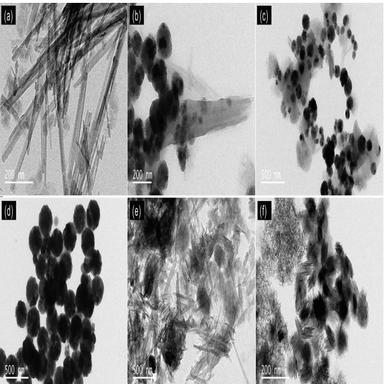
The TEM morphology of various products produced in different solvothermal synthesis conditions: (a) attapulgite nanorods was treated only in water for 24 h (formula 1 in). AT(b) (formula 2 in) or AT-CH2-CH2-CH3 (c) (formula 3 in) was used instead of the AT-NH2 or without AT-NH2 (d) (formulas 4 in). (e) no FeCl3 (formula 5 in tabel 2) was added. (f) organic solvent was replaced by water (formula 6 in tabel 2).